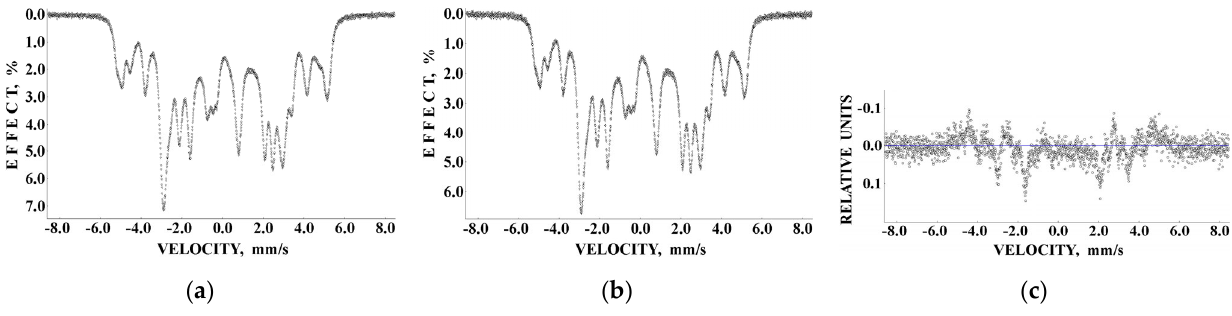
Figure 76. Room temperature Mössbauer spectra of FINEMET ribbons with different permeabilities: F1, µ r = 34,500 ( a ) and F2, µ r = 190,000 ( b ) and their normalized differences ( c ). The Mössbauer spectra were measured in 4096 channels and converted into 2048‑channel spectra. Adapted from Ref. [102] with permission from Elsevier: Materials Chemistry and Physics, Vol. 180, Oshtrakh M.I., Klencsar Z., Semionkin V.A., Kuzmann E., Homonnay Z., Varga L.K., “Annealed FINEMET ribbons: Structure and magnetic anisotropy as revealed by the high velocity resolution Mössbauer spectroscopy”, 66–74, ©2016.